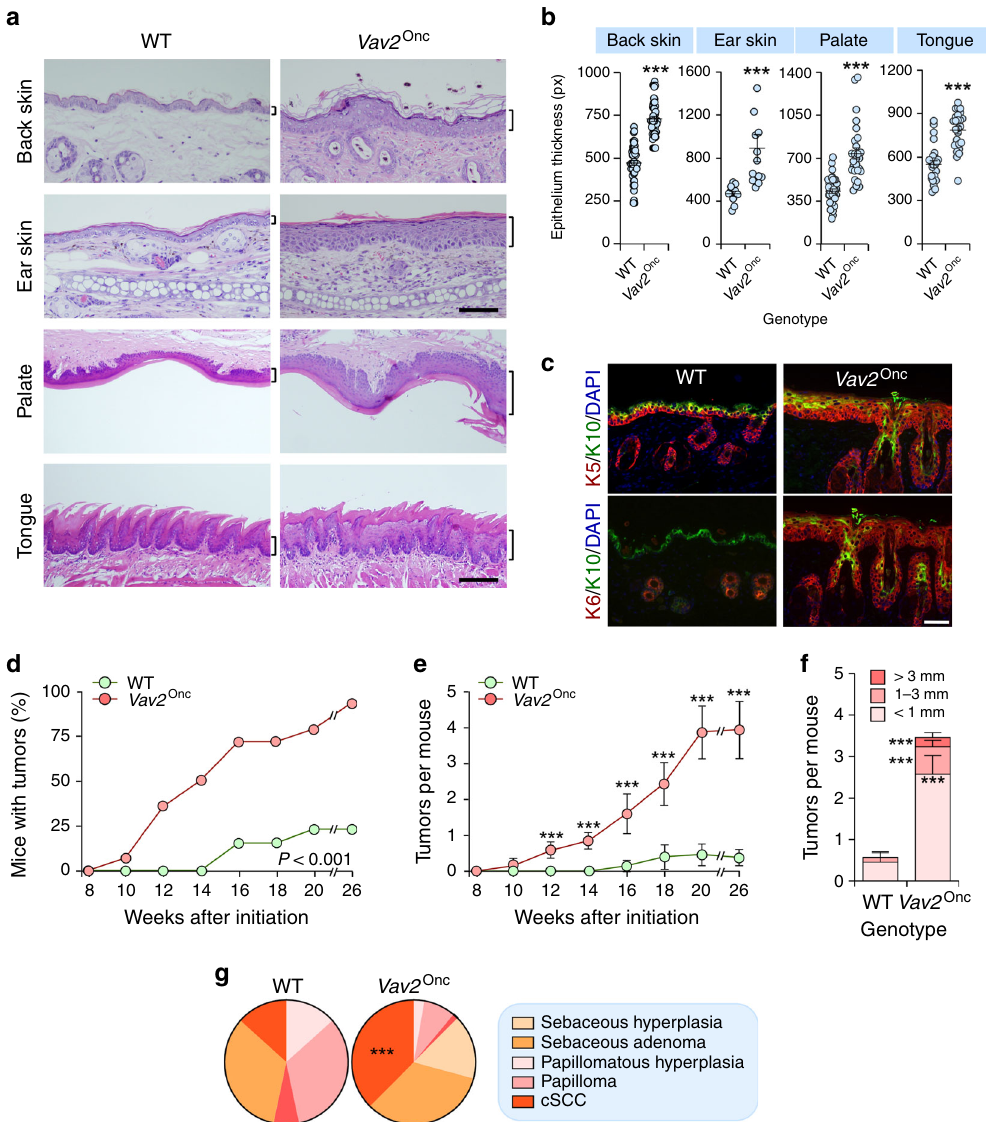
Fig. 3 Upregulated VAV2 signaling creates a protumorigenic niche. a Histological sections of the epithelia from mice of the indicated genotypes. The thickness of the epithelium is indicated with a bracket. Scale bar, 100 (back and ear skin) and 200 (palate and tongue) μ m ( n = 6 animals per genotype). b Thickness of indicated epithelial linings according to the data gathered in a . *** P < 0.0001 (two-tailed Student ’ s t -test, n = 6 animals per genotype). px pixel. c Expression of keratin 5 (K5; top, red color), keratin 6 (K6; bottom, red color), and keratin 10 (K10; both panels, green color) in the skin from the back of animals of indicated genotypes. In all cases, the nuclei of cells were labeled with DAPI (blue color). Scale bar, 50 μ m ( n = 3). Penetrance ( d ) and multiplicity ( e ) of tumors generated in mice of the indicated genotypes upon a single topic DMBA application at postnatal day 3. The differences between genotypes were statistically signi fi cant from week 12 onwards ( P < 0.0001, two-tailed Student ’ s t -test). n = 24 and 31 WT and Vav2 Onc/Onc mice, respectively. f Size distribution of the tumors at the endpoint of the experiment shown in d . *** P < 0.0001 (two-tailed Student ’ s t -test, n as in d ). g Tumor type distribution at the endpoint of the experiment shown in d . P < 0.0001 (Chi-squared test, n = 15 and 72 WT and Vav2 Onc/Onc tumors, respectively). In b , e , and f , data represent the mean ± SEM. Source data for this fi gure are provided as a Source Data fi effects included the downregulation and upregulation of gene line with the induction of the combination of proliferative and signatures characteristic of late epidermal differentiation- and stem cell like-programs, we found that the epidermis of epidermal cell progenitor-associated programs (Fig. 5b, upper Vav2 Onc/Onc mice reacts to the topic administration of a single dose of TPA with more rapid and wide proliferative responses panels), respectively. Perhaps more importantly, we found the than the skin from control animals (Fig. 5c). We also observed enrichment of gene signatures related to cSCC tumor initiating that the primary keratinocytes from newborn Vav 2 Onc/Onc mice cells and embryonic stem cells in the Vav2 Onc -induced tran- scriptome (Fig. 5b, bottom panels). No statistically signi fi cant generate higher numbers of induced pluripotent stem (iPS) cell overlaps are found with the transcriptomes of normal hair fol- colonies than the WT counterparts upon transfection with the Yamanaka ’ s cocktail (Fig. 5d). These observations indicate licle stem cells, indicating that Vav2 Onc triggers an aberrant that the upregulation of Vav2 signaling leads to a stem cell-like dedifferentiation process more similar to general stem cells than state of regenerative proliferation and delays in keratinocyte to those found in the most undifferentiated skin precursors. In